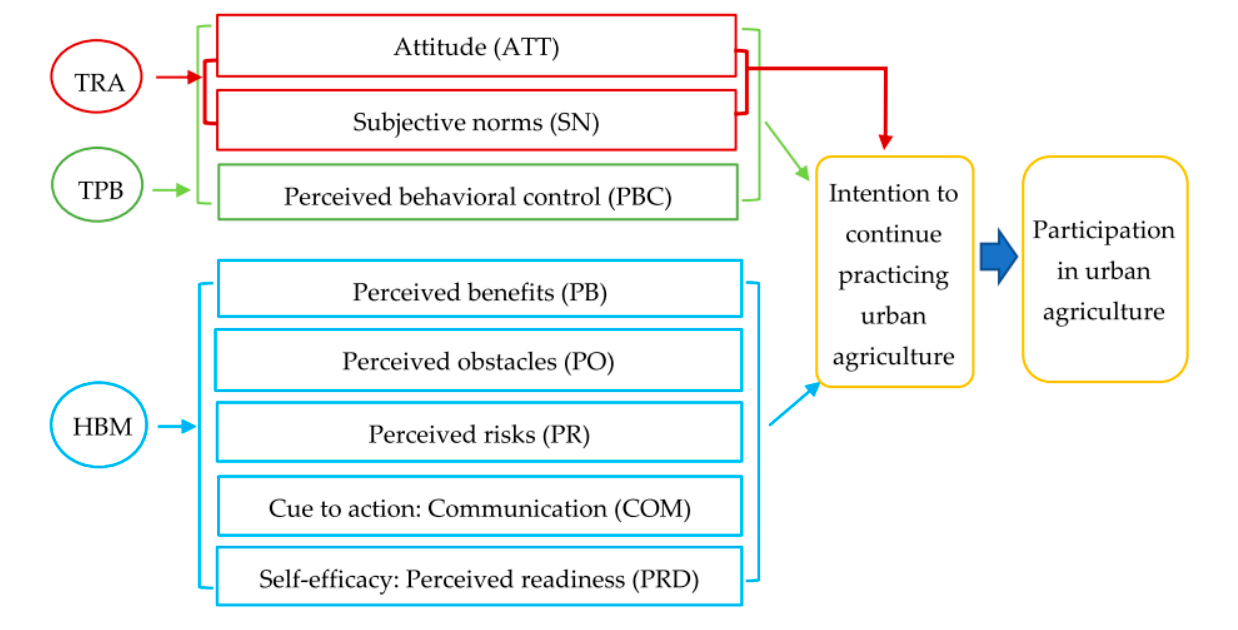
Figure 1. The integrated psychological model employed in this study.